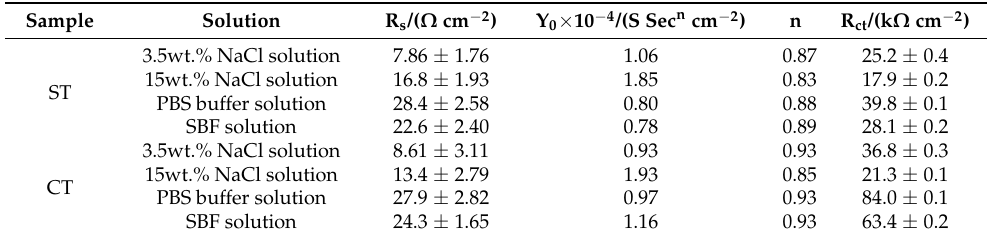
Figure 5. Equivalent circuit used for impedance spectra analysis for ST and CT in the four solutions. Table 3. Fitting results of EIS tests for ST and CT in the four solutions.